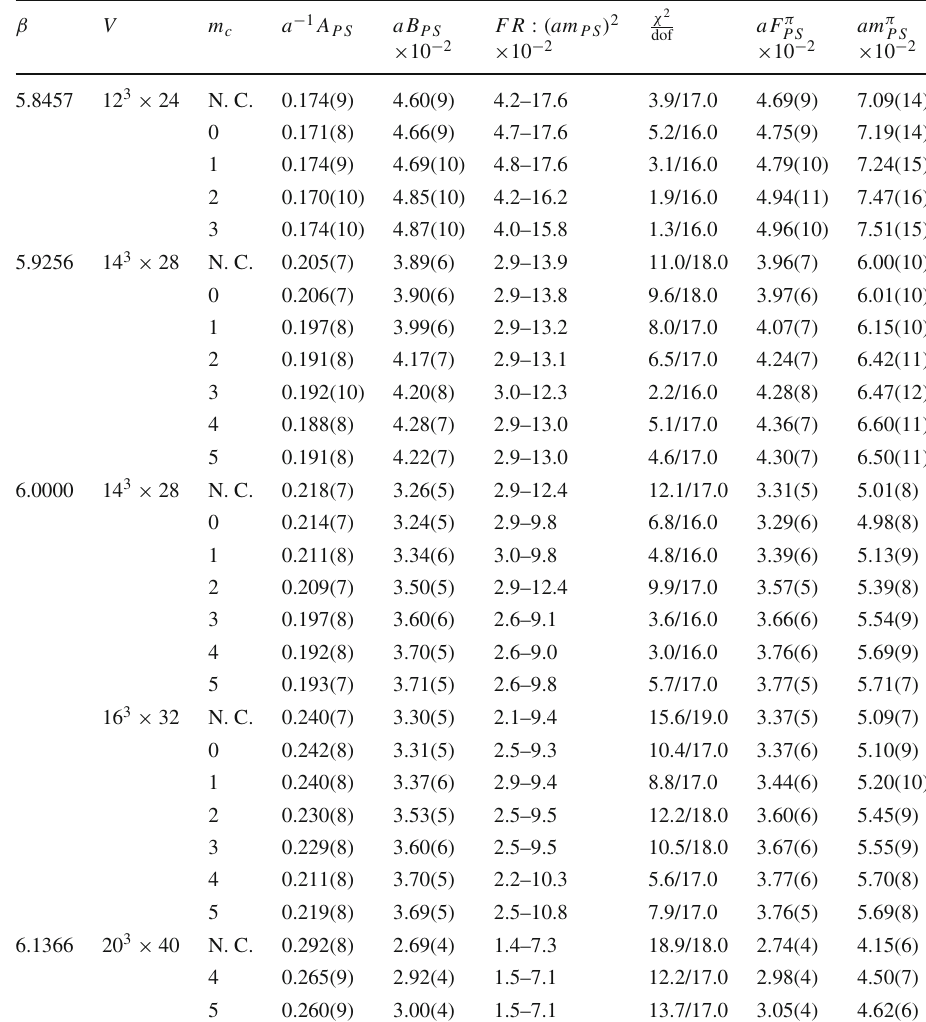
Table 32 The fitting results of the slope a − 1 A PS and intercept aB PS by the function aF PS = a − 1 A PS x + aB PS , [ x = ( am PS ) 2 ] together with the computed results of the intersections aF π and am π PS